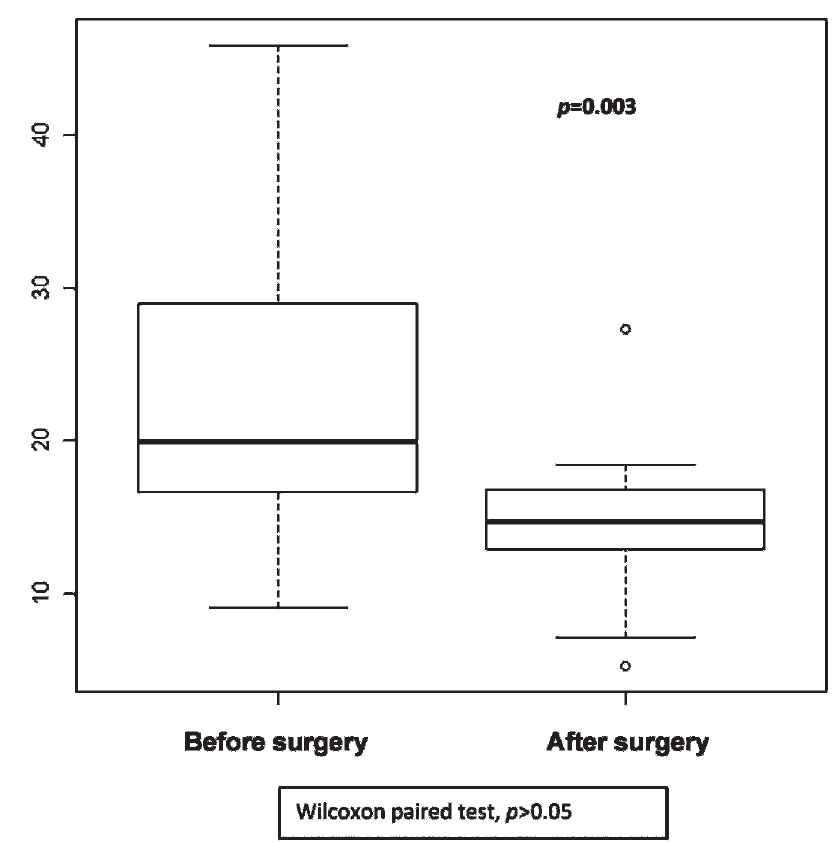
Figure 4 - Sphincter Asymmetry Index scores before and after surgery in 23 patients who underwent perineal